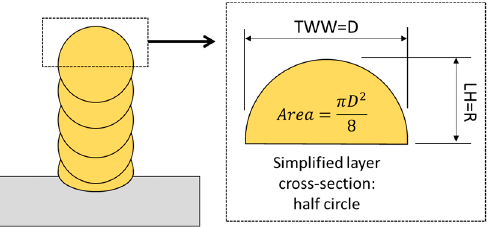
Figure 4. Simplified model for the cross-sectional layer geometry and its correlation with the deposition parameters. deposition